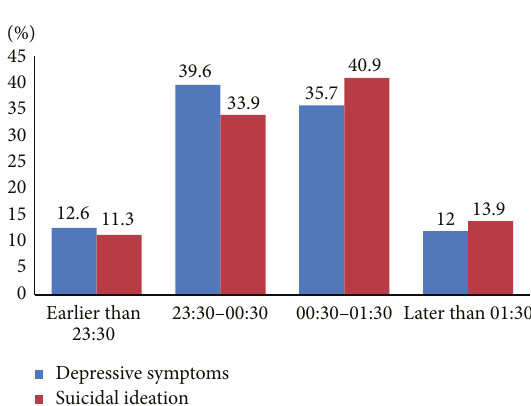
Figure 2: Prevalence of depressive symptoms and suicidal ideation according to